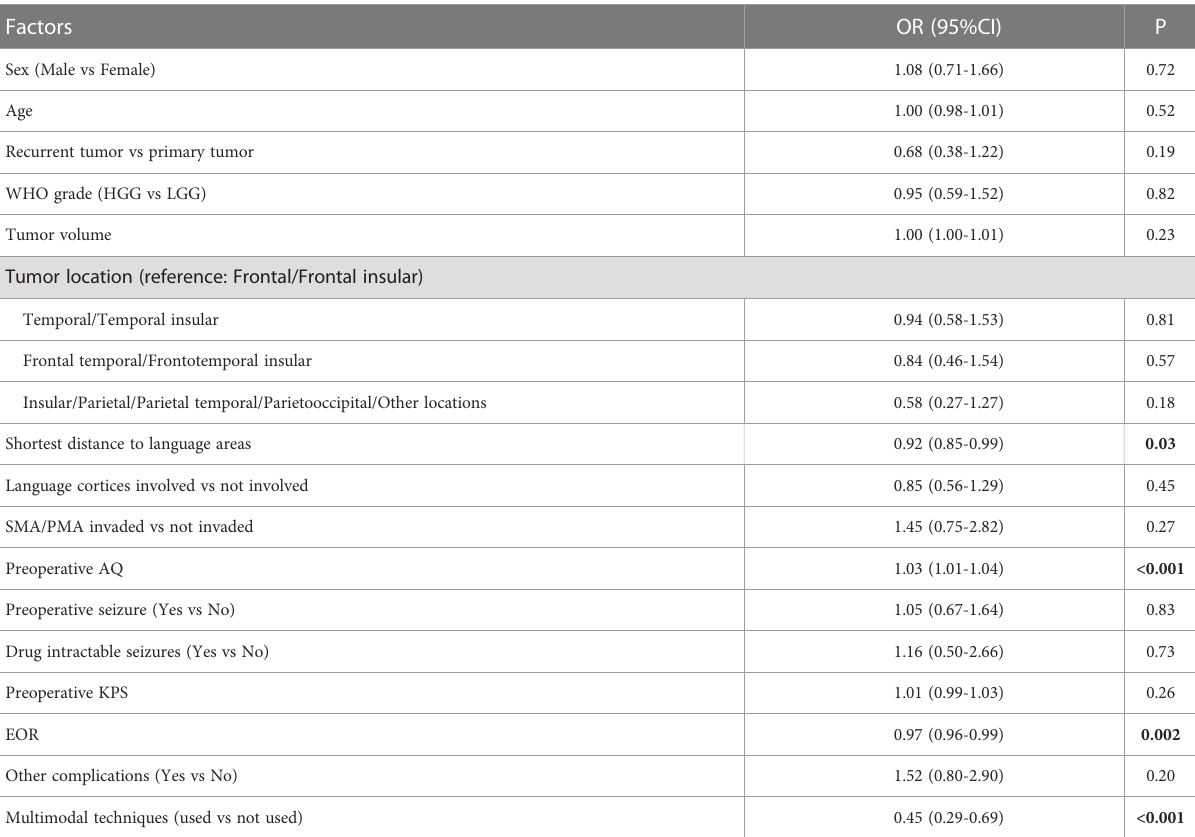
Boldface type indicated statistical signi fi